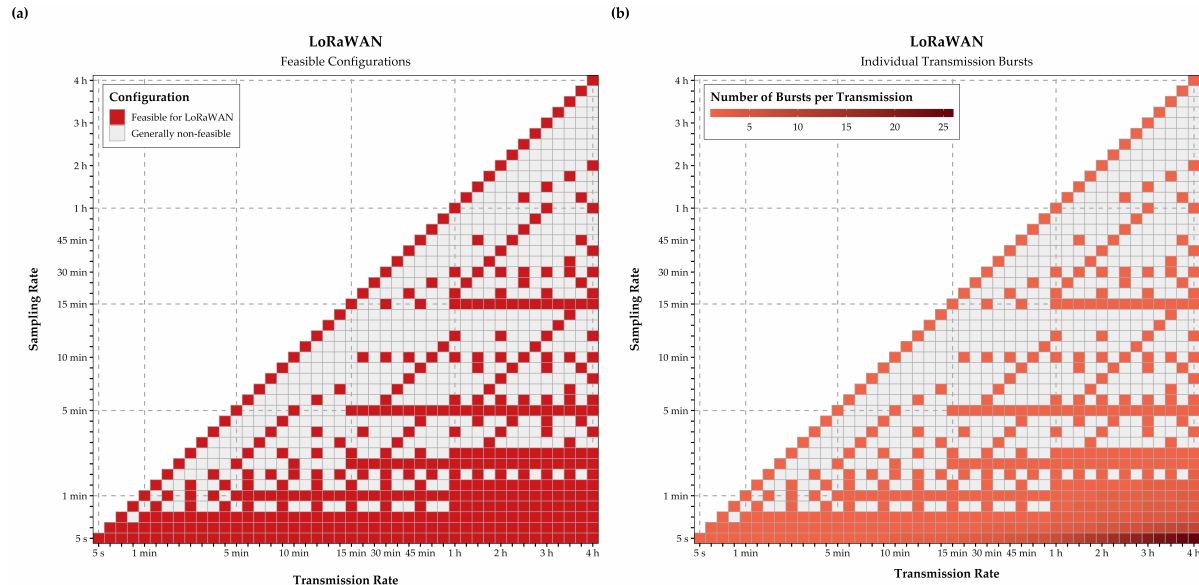
Figure 5. Transmission bursts ( b ) required to enable the implementation of configurations ( a ) with high sampling and low transmission intervals within the constraints of